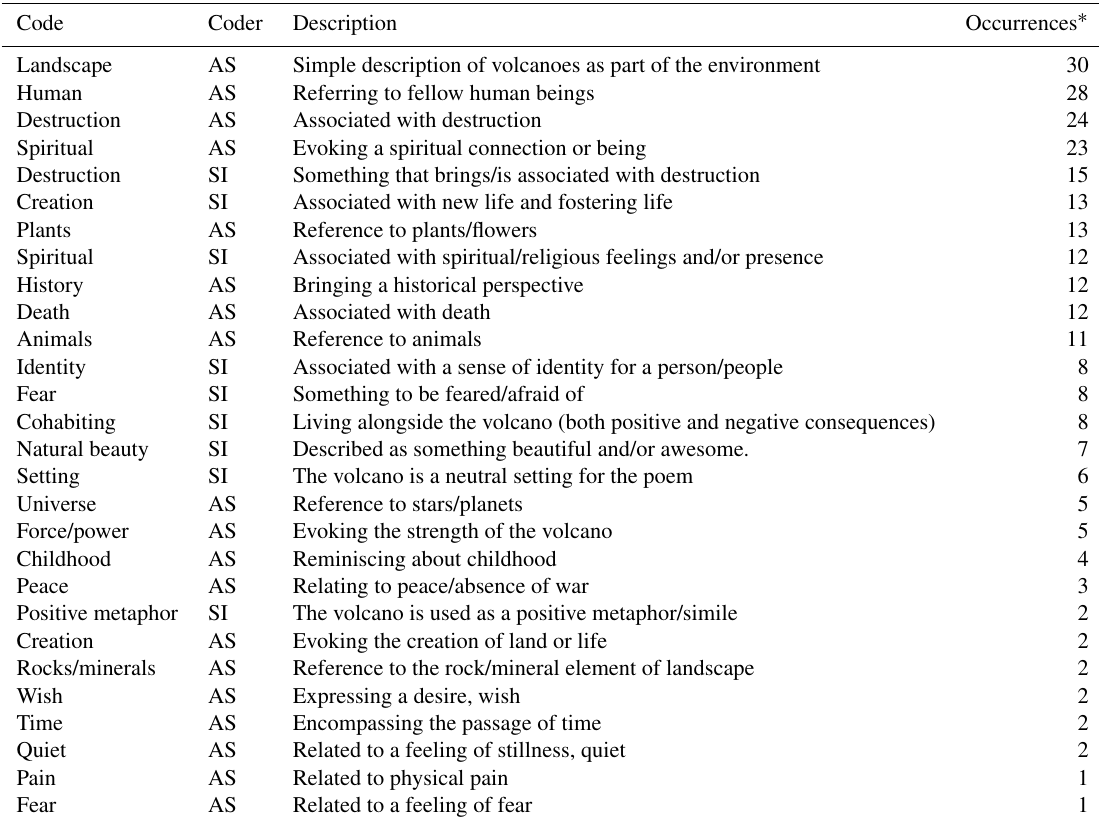
Table 2. The codes that emerged from an individual content analysis of the 34 poems, arranged according to the number of times they occurred (AS: Arianna Soldati; SI: Sam Illingworth).